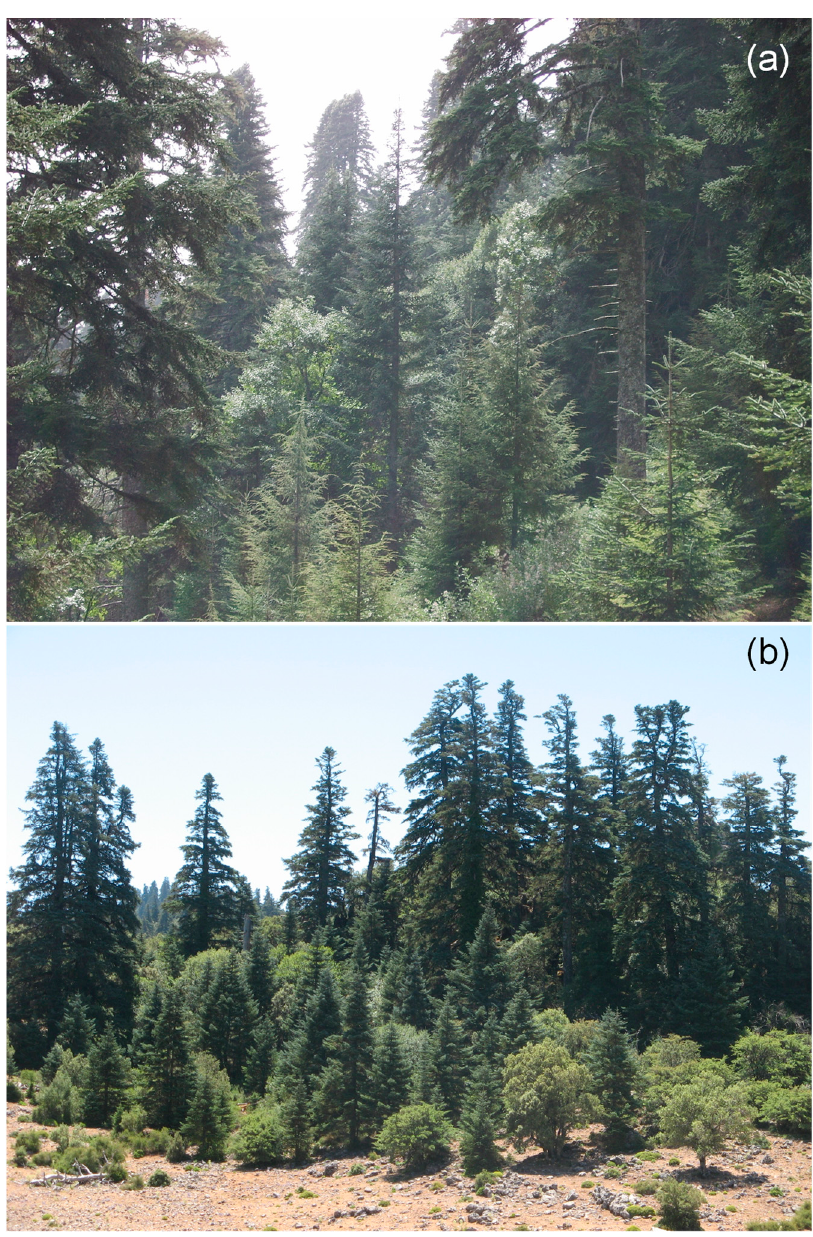
Figure 6. High tree species diversity in Abies marocana forest of Talassemtane ( a ) and Tazaot ( b ) ranges, north Morocco. Photo: Juan Carlos